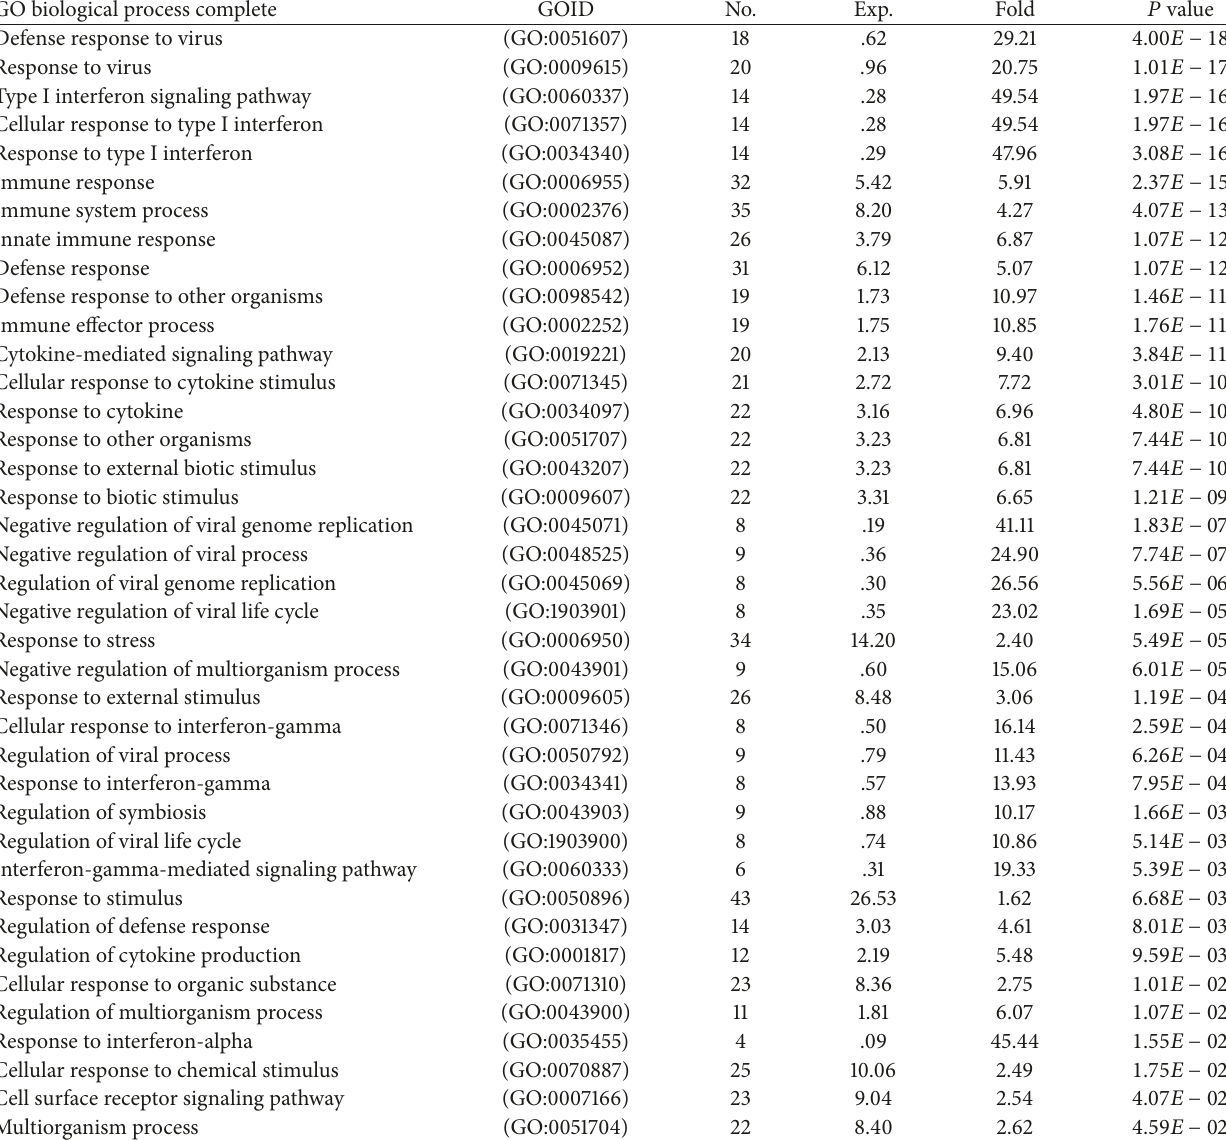
Figure 4: Similarity matrices. Similarity matrices between weight vectors learned over all 10 folds of data and all four methods. Warmer colors correspond to higher similarity (stability) and cooler tones to lower similarity. SLDSS (upper left squares) has the highest similarities among all methods. Table 5: PANTHER overrepresentation analysis results. No.: number of associated genes; Exp.: expected number of genes by chance; Fold: number of times